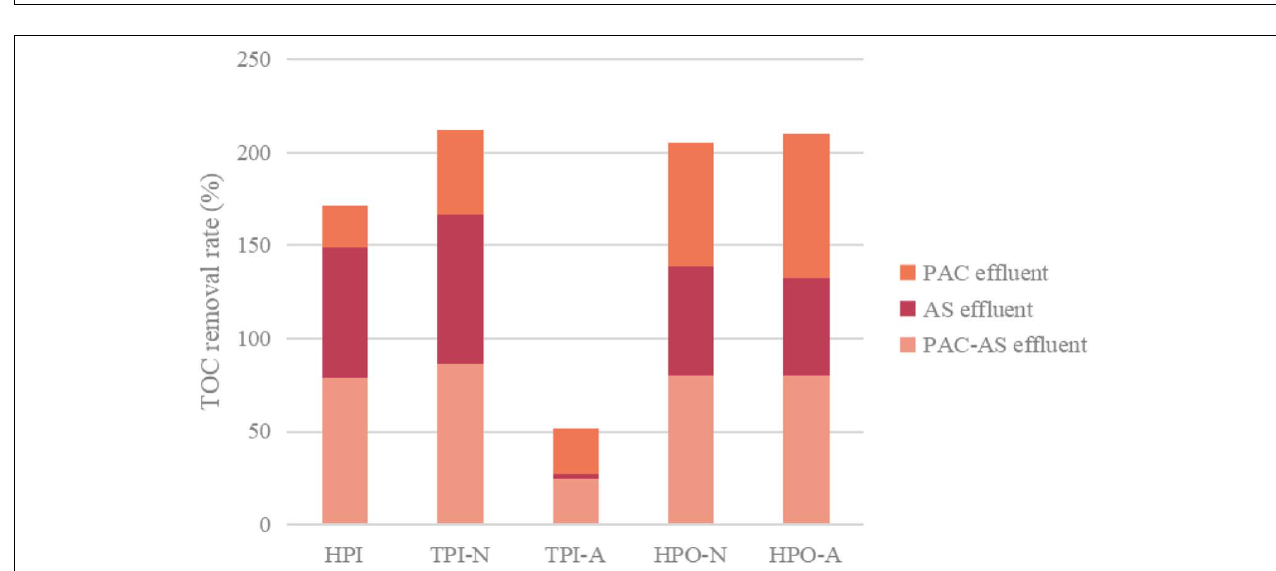
FIGURE 7 | Comparison of molecular weight distribution of organic matter in waste water before and after treatment.